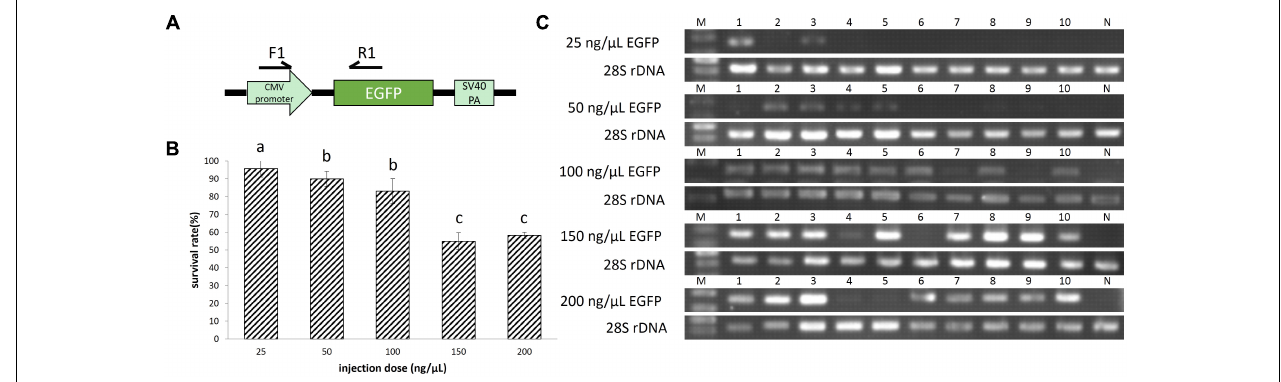
FIGURE 1 | (A) The enhanced green fluorescent protein (EGFP) unit in the plasmid pEGFP-C1. (B) Survival rates of EGFP transgenic embryos. A total of 624 embryos were injected. The survival rate was transformed to arcsine square root, then analyzed by ANOVA followed by Student–Newman–Keuls method. Symbols with the same indicate groups that are not significantly different. (C) Detection of EGFP transgene by PCR. M represented marker, lane 1–10 represented 10 individuals, and N represented negative control.